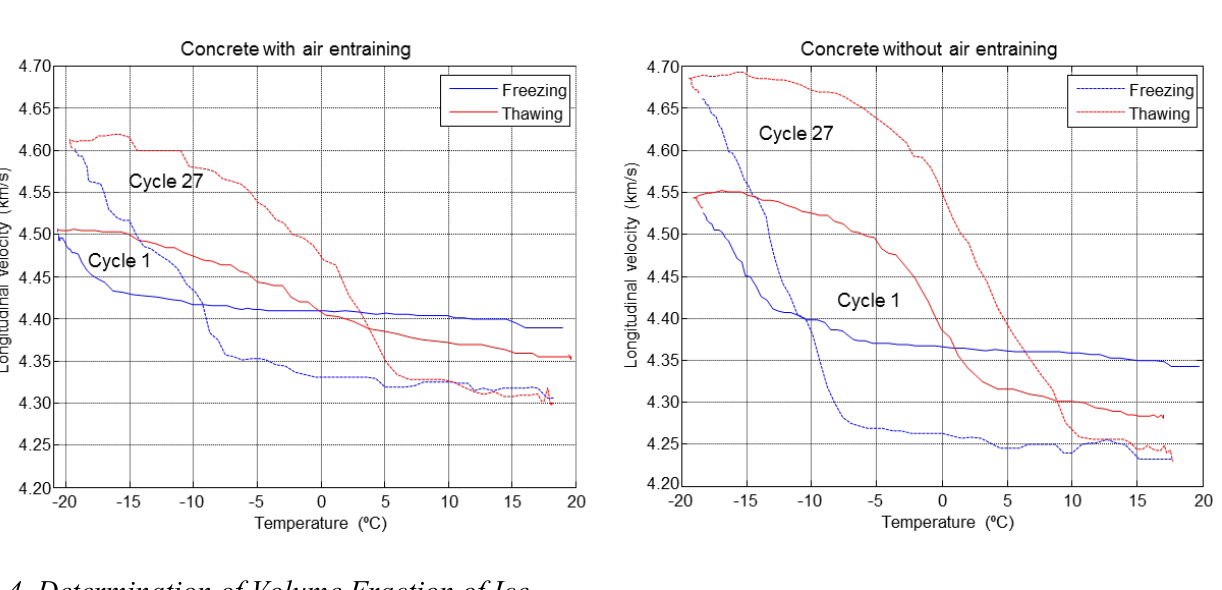
Figure 18. Behaviour of ultrasonic velocity in F-T cycles, 1 and